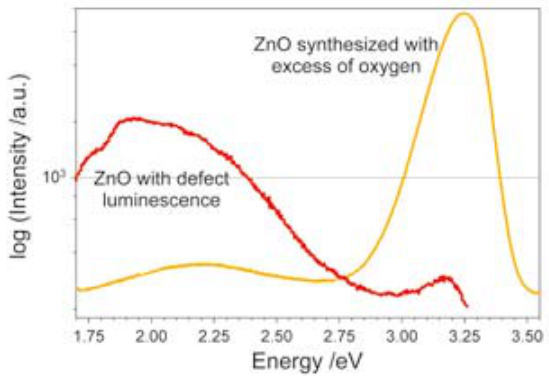
Fig. 4 PL spectra of ZnO from the gas phase synthesized at Φ = 0.5 (red graph) and with extreme excess of oxygen.